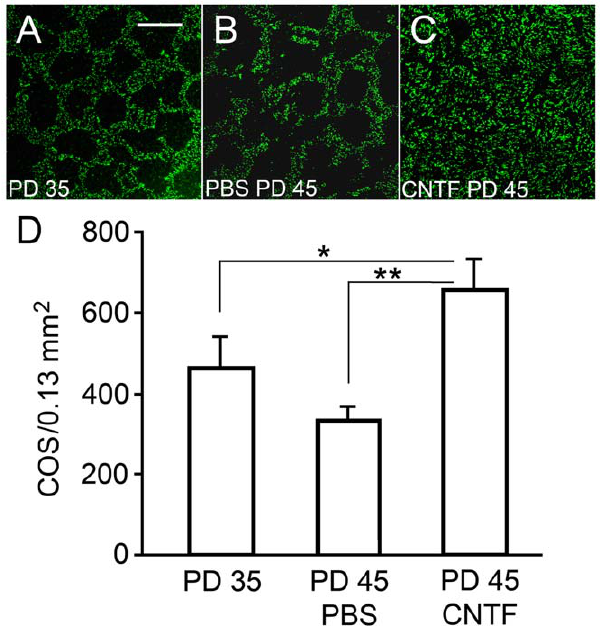
Figure 7. Regeneration of COS induced by CNTF treatment. Retinas (superior regions) of S334ter-3 rats at PD 35 were treated with either CNTF or PBS and harvested 10 days after treatment. Whole- mounted retinas of PD 35 (A, before treatment), PD 45 treated with PBS at PD 35 (B), and PD 45 treated with CNTF at PD 35 (C) were stained with PNA. PNA positive cells in CNTF treated retinas are more than those in either PBS treated retinas or PD 35 retinas. Quantitative analysis showed that PNA-positive cells are significantly more in the PD 45 CNTF treated retinas (657 6 76, n=4) than in the PD 35 retinas (467 6 73, n=3), or PD 45 retinas treated with PBS (334 6 33, n=3) (D, mean 6 SD), indicating regeneration of COS in response to CNTF treatment. Asterisk indicates P , 0.05; double-asterisk indicates P # 0.01 (ANOVA analysis and Bonferroni test). Scale bar: 100 m m.